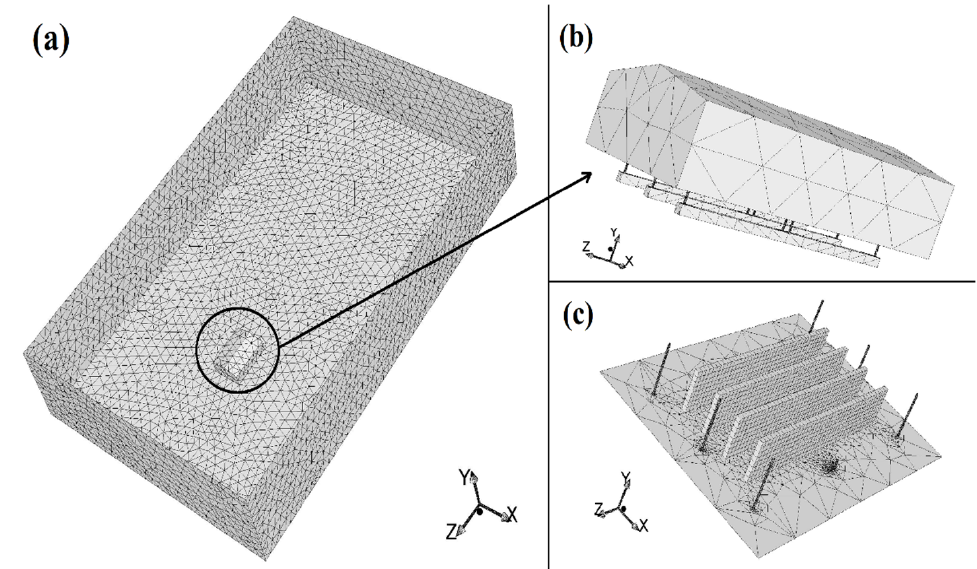
Figure 3. Mesh used to simulate the calculation domain ( a ), the greenhouse equipped with the rock bed heating system ( b ), and the crop ( c ). bed heating system ( b ), and the crop ( c